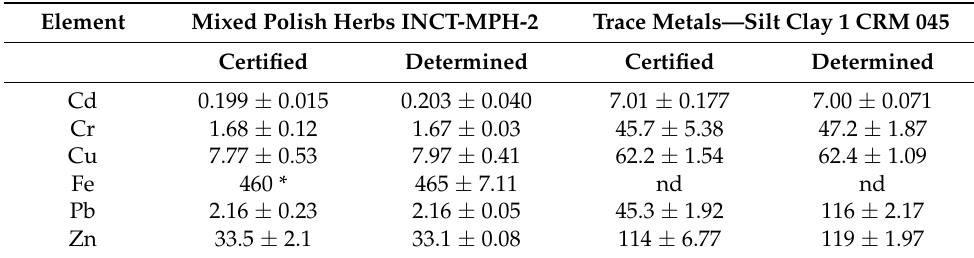
Table 4. The analysis of certified reference materials (in mg/kg, n =